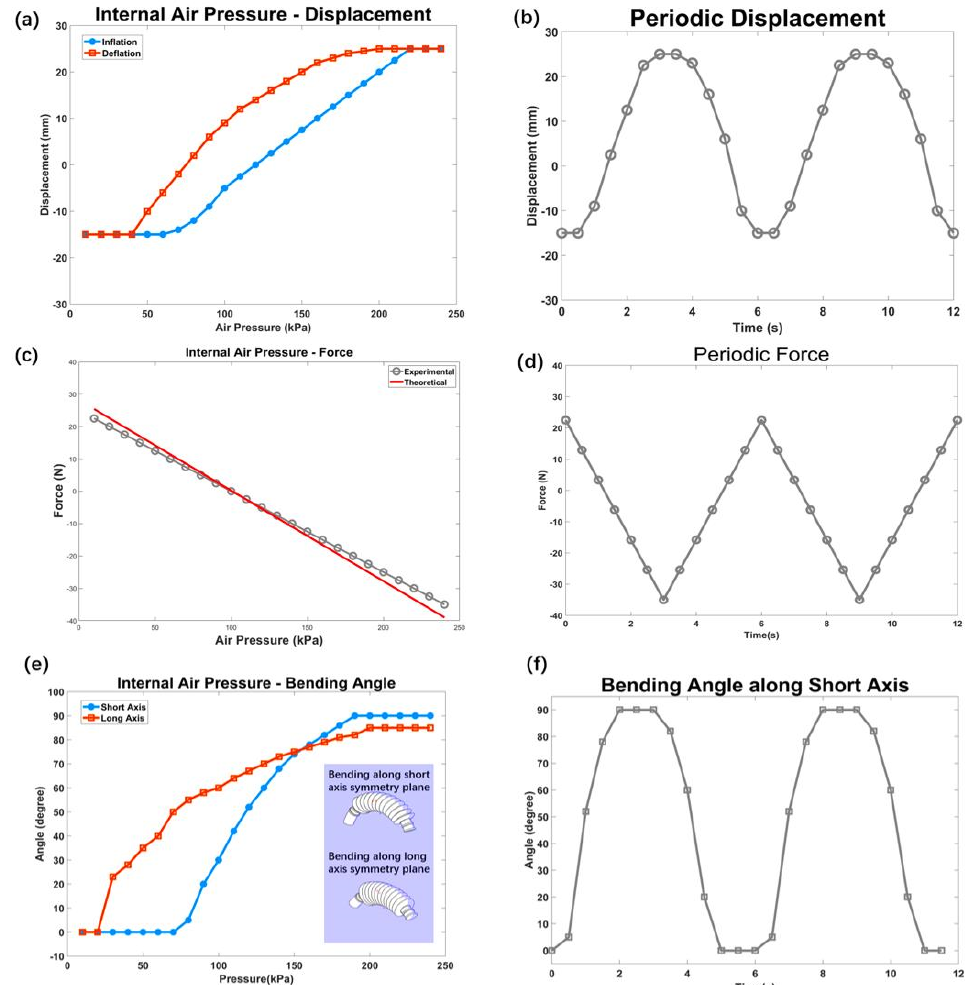
Figure 7. Results’ curves. ( a ) Hysteresis curves: relationship between the internal air pressure and output displacement during inflation and deflation; ( b ) periodic displacement curve: output displacement in two cycles; ( c ) relationship between the internal air pressure and output force; ( d ) periodic force curve: output force in two cycles; ( e ) bending angle curves: relationship between internal air pressure and bending angle along short- and long-axis symmetry plane; ( f ) periodic bending angle curve: bending angle along short axis symmetry plane.